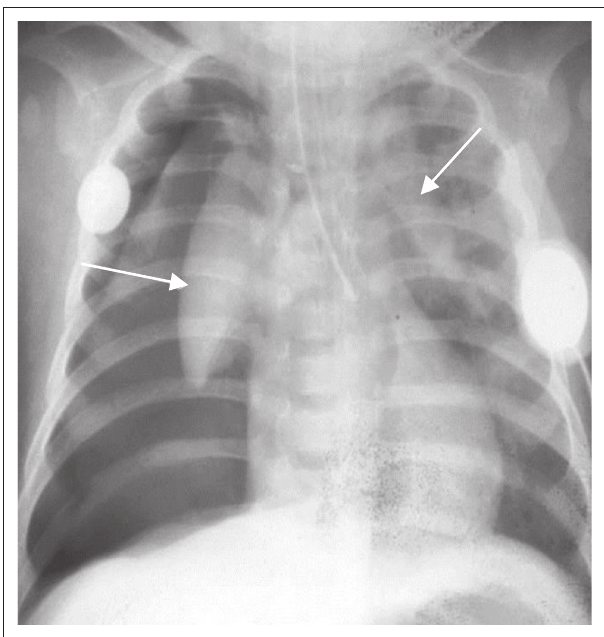
FIGURE 8: ʻAngel’s wing’ sign (arrows) of the thymus in a patient with pneumomediastinum. The patient also has a bilateral pneumothorax.